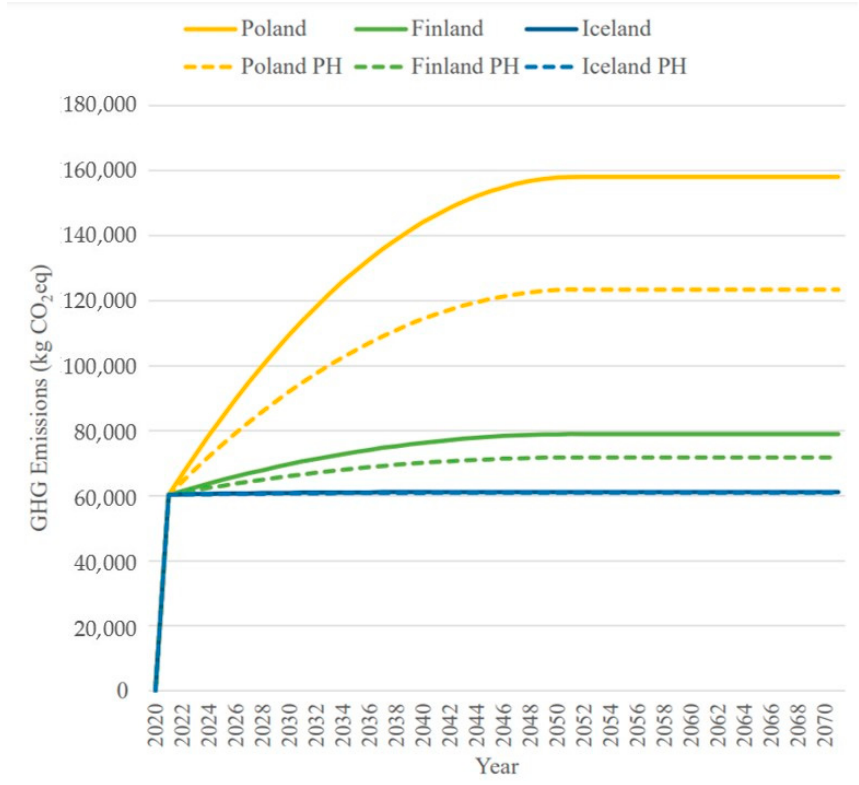
Figure 8. Lifetime GHG emissions over a 50-year timeframe in three geographic locations: Iceland, Poland, and Finland. Scenario 1, represented by the solid lines, utilizes current building standards for each respective country. Scenario 2, represented by dotted lines, reflects the Passive House standard.